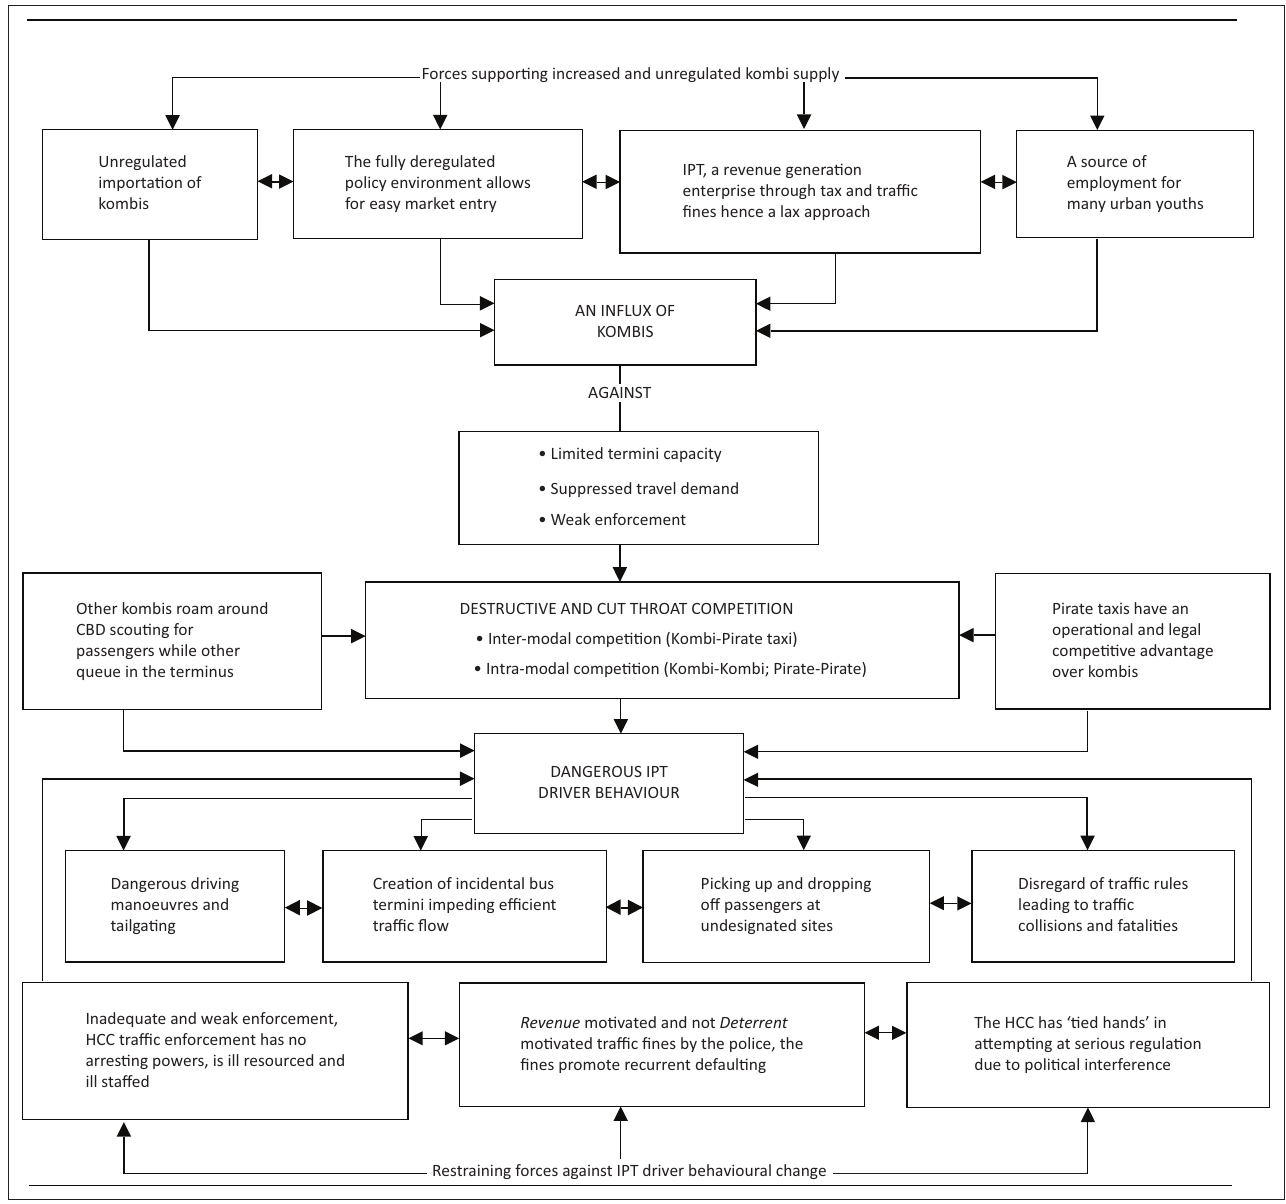
FIGURE 7: The informal public transport driver behaviour and regulatory policy reinforcing loop in